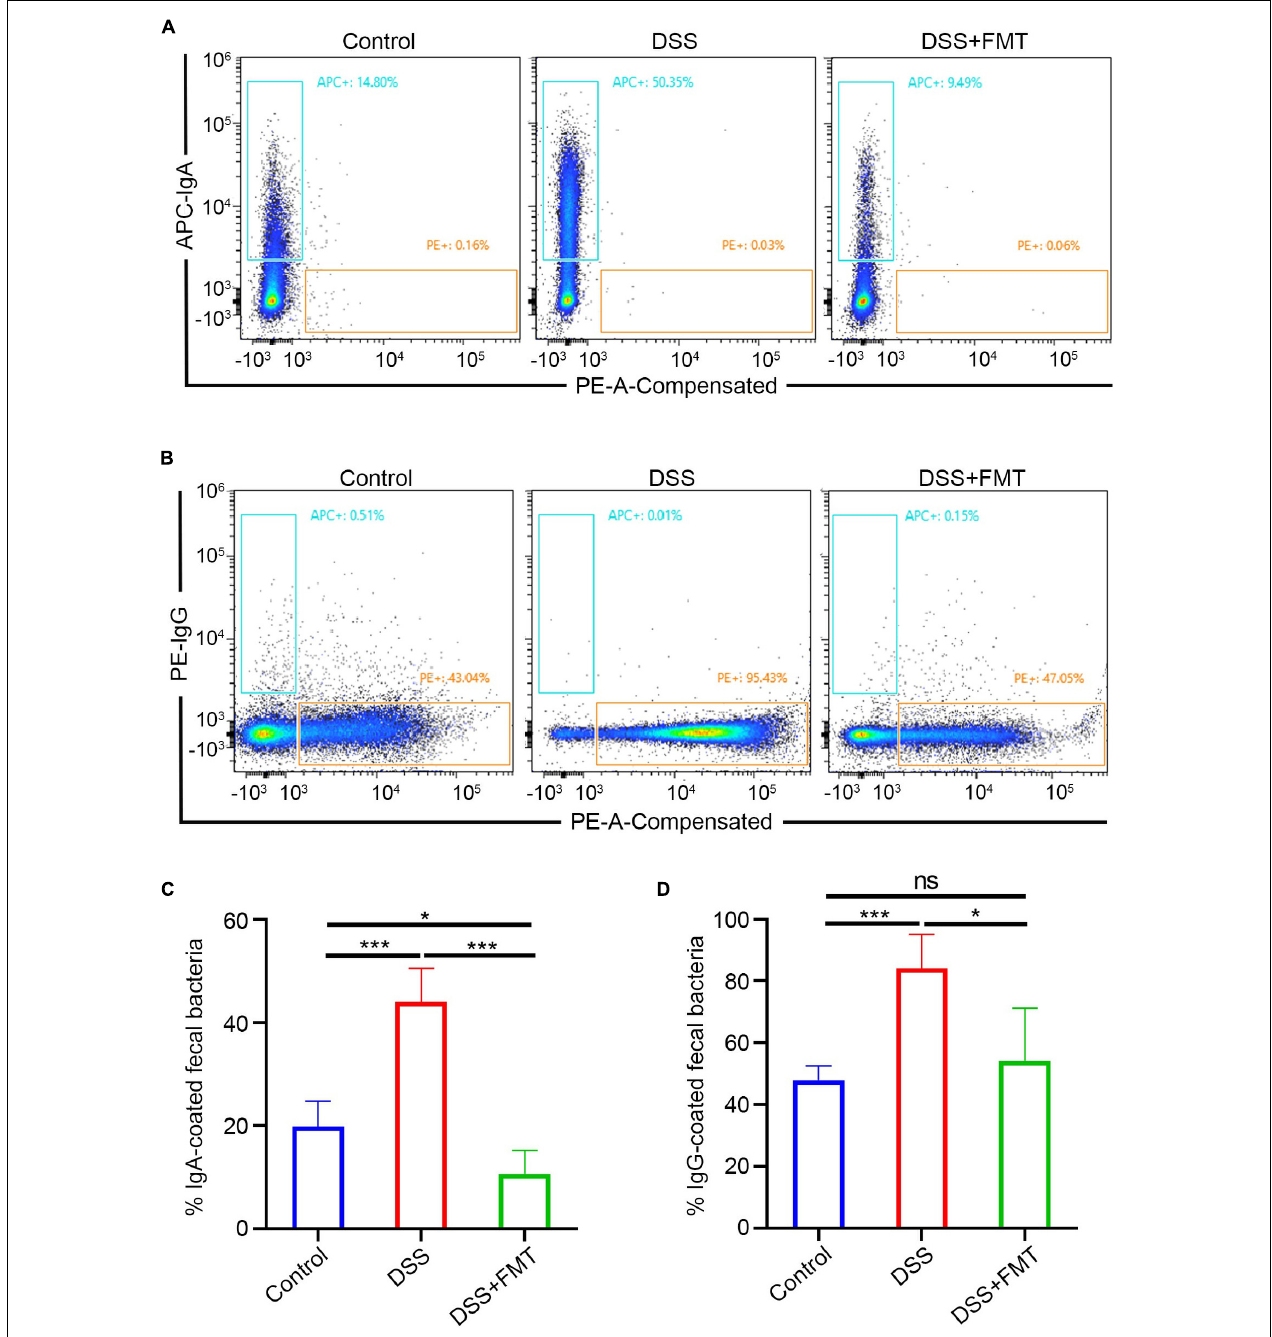
FIGURE 8 | IgA/G + gut bacteria were determined by flow cytometry. (A,C) Fecal IgA + bacteria by FACS. (B,D) Fecal IgG + bacteria by FACS. * p < 0.05, *** p < 0.001, ns means no significance